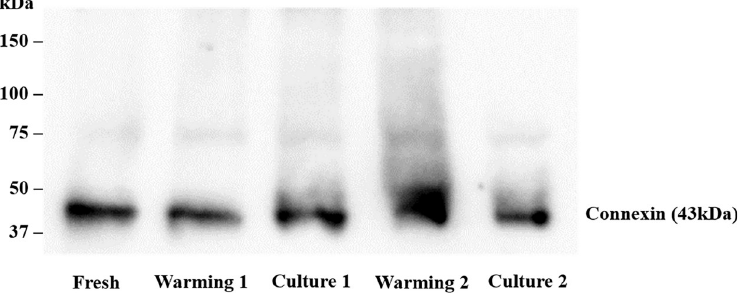
Fig 4. Connexin expression on testicular tissue from prepubertal cats. Warming 1 (tissue warmed at 37˚C), culture 1 (warming 1 followed by culture for 24h), warming 2 (tissue warmed at 50˚C), culture 2 (warming 2 followed by culture for 24h).